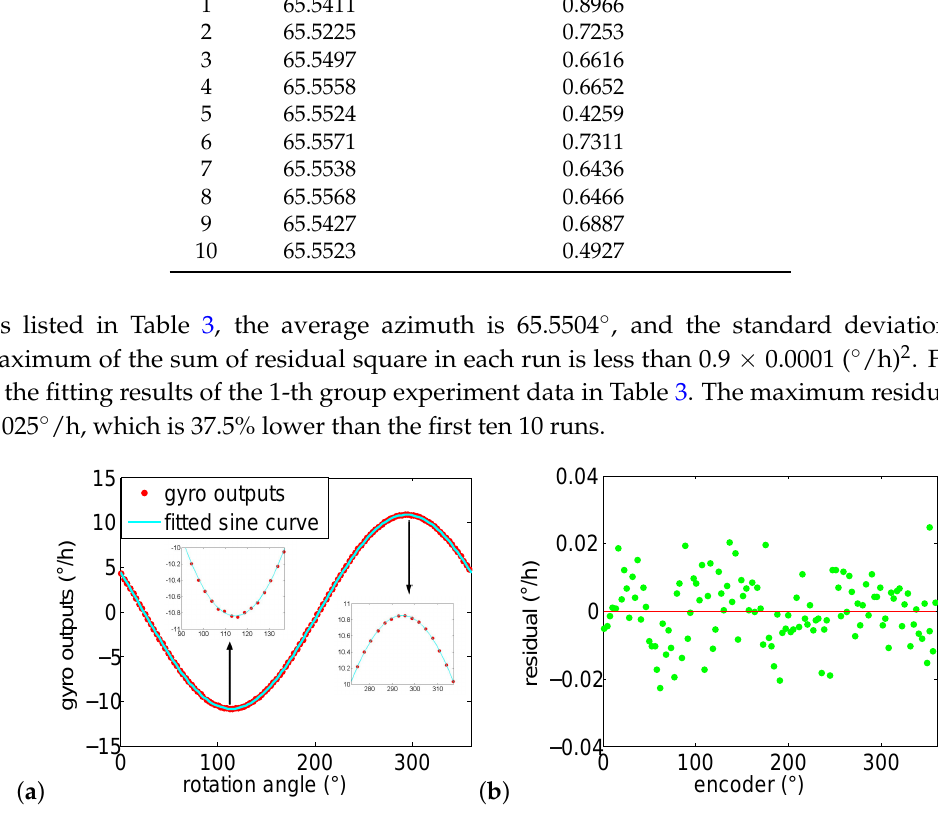
Figure 13. Gyro outputs fitting results when the number of measurement points n = 120. ( a ) Fitting curve when n = 120; ( b ) Residual of the corresponding fitting